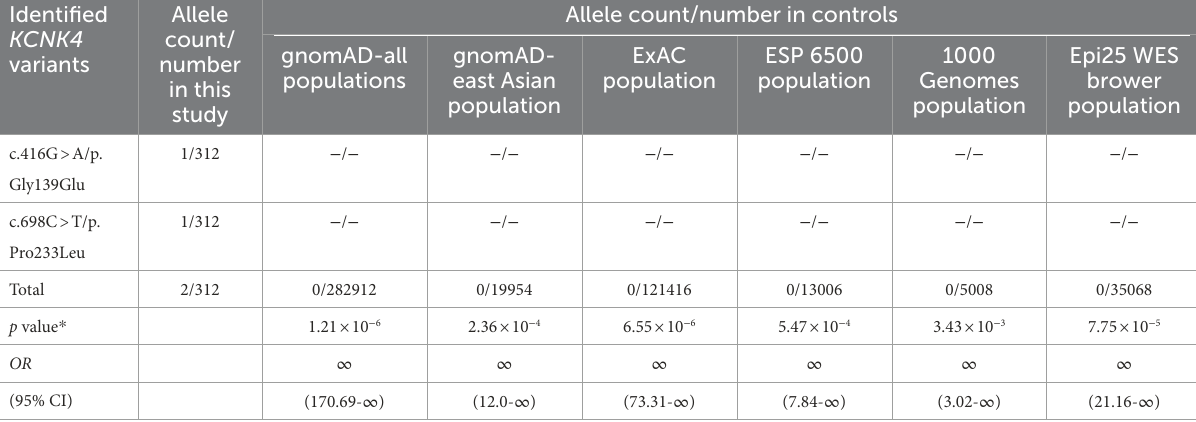
TABLE 2 Aggregate analysis of the frequency of KCNK4 variants identified in this